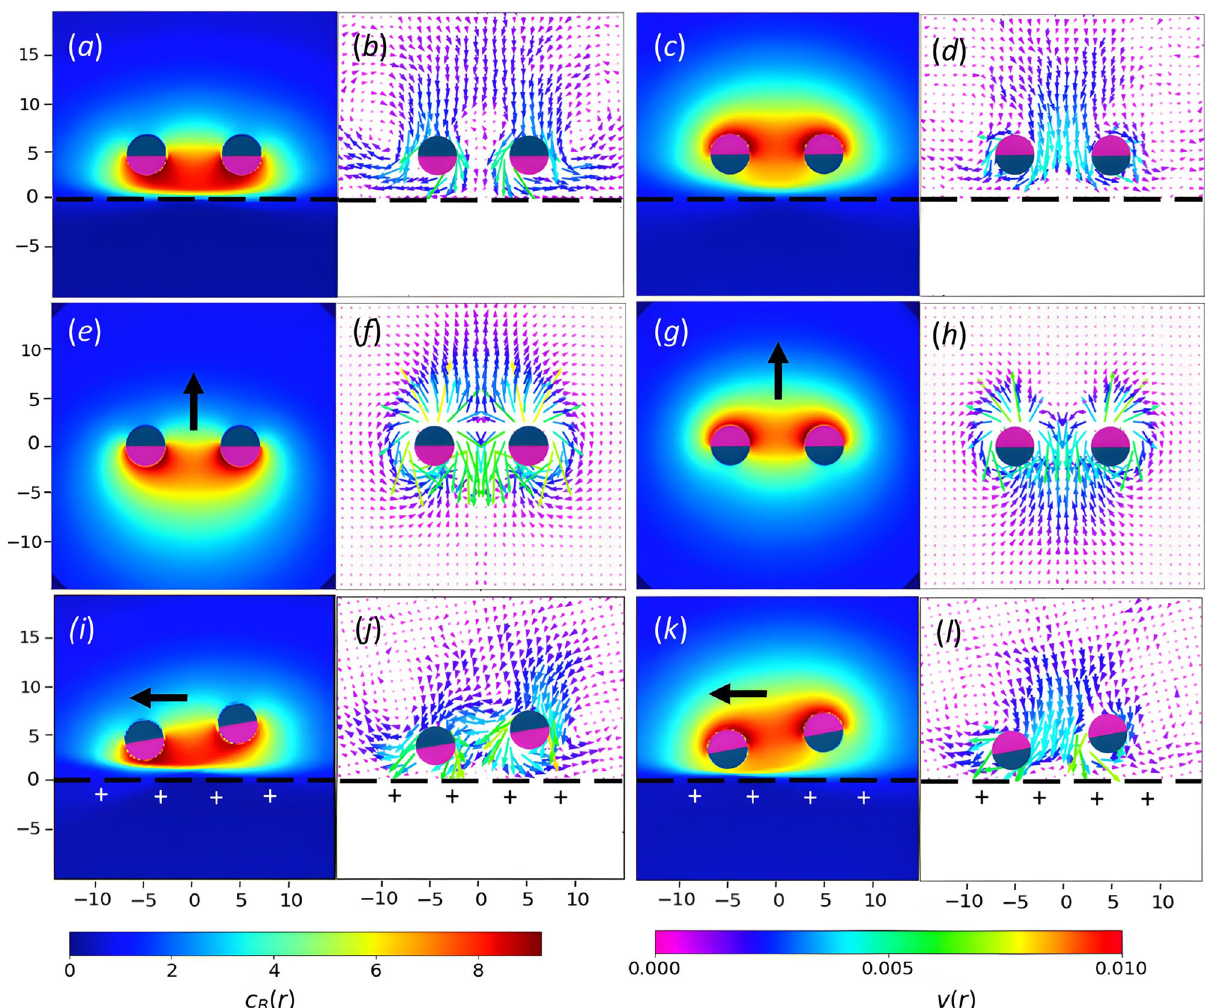
Fig. 2 Concentration and velocity fi elds of a torus near the wall. a – d The concentration c B ( r ) ( a ) and fl uid velocity fi eld v ( r ) ( b ) for a hovering backward- moving torus for g = 0.15. The concentration is shown in pseudocolour representation and the fl uid velocity orientation is shown by the vectors; the colour indicates the velocity magnitude. Corresponding colour bars for the concentration and fl uid velocity are displayed at the bottom of the fi gure. c , d are the same fi elds for a hovering forward-moving torus for g = 0.07. The dashed line indicates the location of the wall at z = 0. e – h ( e ) and ( f ) The concentration c B ( r ) ( e ) and fl uid velocity fi eld v ( r ) for a backward-moving torus in the bulk fl uid (no gravitational force); g , h The same fi elds for a forward-moving torus in the bulk fl uid. i – l Same as ( a – d ) but including the effect of charge-dipole interactions with strength ϵ cd = 0.2. The + symbols indicate the sign of electric charge density on the surface. For fi gures where a wall is present, indicated by dashed horizontal lines, the ordinates refer to the z distance from the wall, while the abscissas gives the distance x along a plane parallel to the torus orientation vector that cuts the torus through its center. The black arrows indicated the direction of motion of moving tori in all panels. The blue colour corresponds to the non-catalytic surface, and the red colour corresponds to the catalytic surface, respectively.